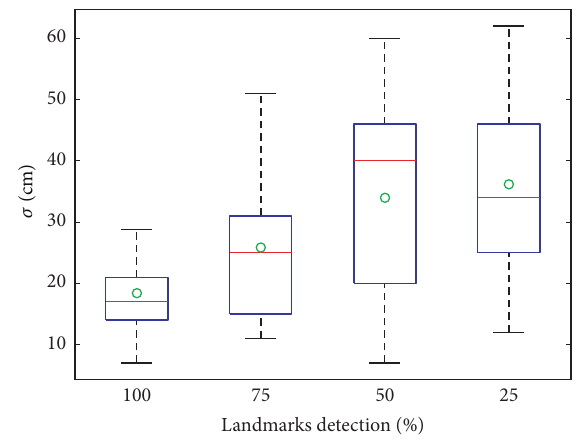
Figure 7: Uncertainty of the localization system when the per- centage of detected landmarks changes. Green circles represent the average error, red lines represent the median, black dotted lines represent the minimum and maximum values, and blue rectangles represent the 25%–75%